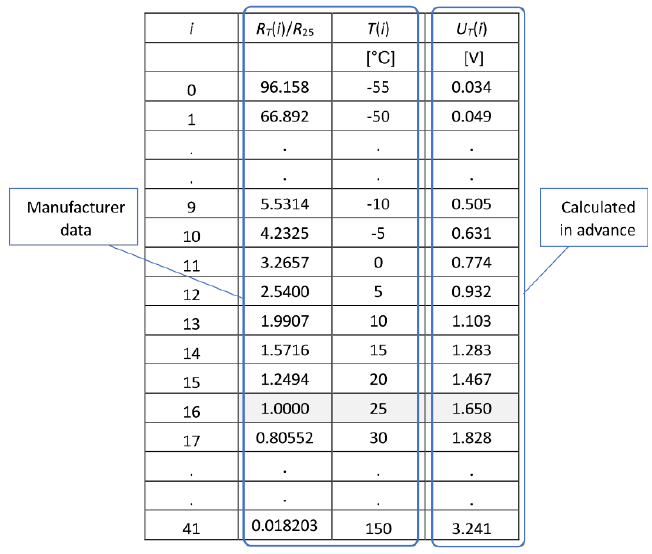
Figure 5. Look-up table principle.